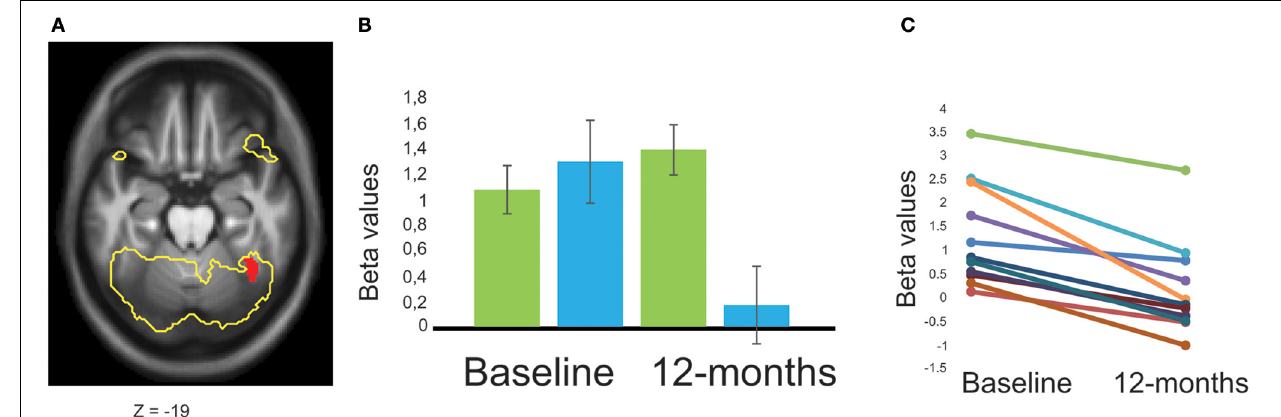
FIGURE 4 | Group-by-time interaction effect, comparing BOLD-signal intensity in patients with Parkinson’s disease with or without MCI. (A) A significant group-by-time interaction effect (red) was shown in the right fusiform gyrus comparing patients with Parkinson’s disease and MCI ( n = 11) to patients without MCI ( n = 28). The task-specific activation for all included participants with Parkinson’s disease are presented as a yellow outline to illustrate the contrast between 2-back working-memory processing and